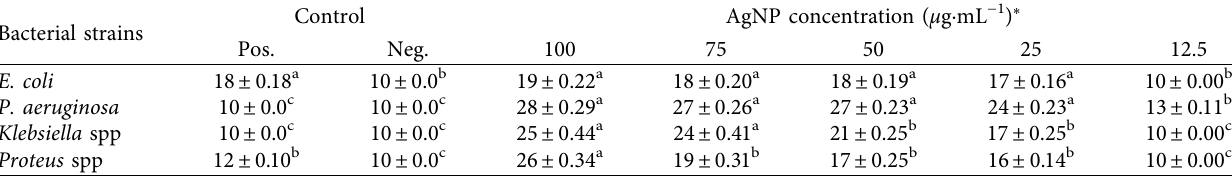
Table 1: Te diameter of the inhibition zone (mm) of AgNPs against the selected bacterial strains.